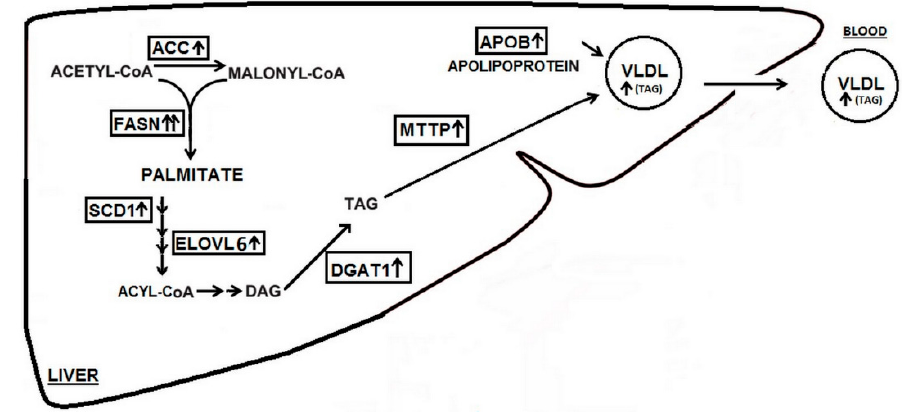
Figure 5. Scheme illustrating the plausible effects of fatty acids extracted from chronic kidney disease (CKD) patients’ serum on the expression of genes associated with lipid synthesis and release in hepatocyte. ACC —acetyl-coenzyme A carboxylase, FASN fatty acid synthase, SCD1 —stearoyl-CoA desaturase, ELOVL6 —fatty acid elongase 6 , DGAT1 —diacylglycerol O -acyltransferase 1, MTTP — microsomal triglyceride transfer protein, ApoB —apolipoprotein B, DAG—diacylglycerol, TAG— triacylglycerol, VLDL—very low density lipoprotein.